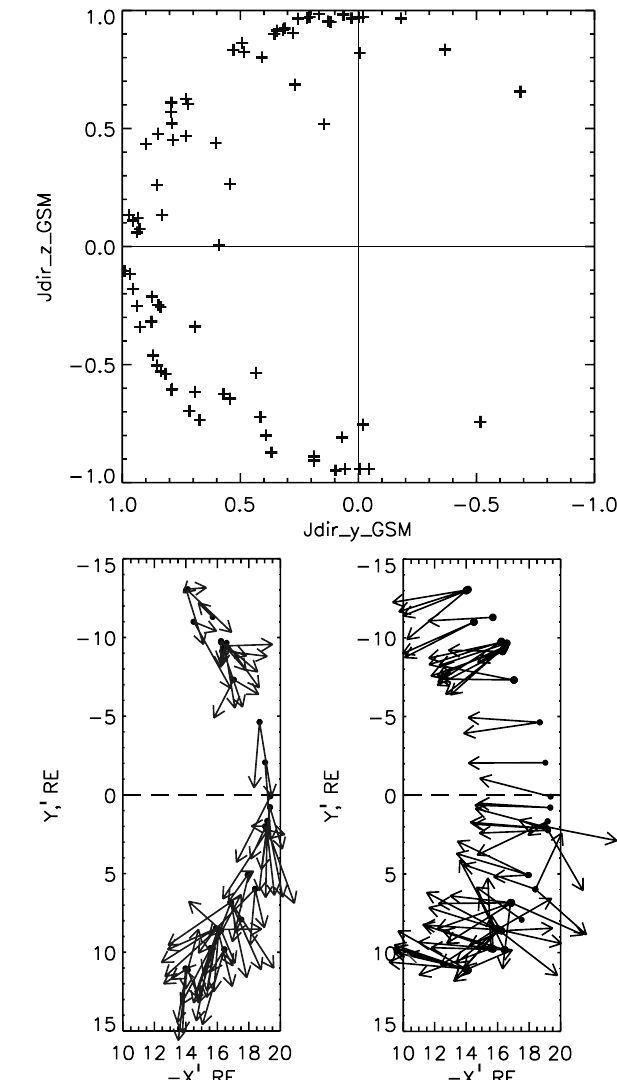
Fig. 7. Electric current and curvature directions. Upper panel: Distribution Y and Z components of the unit vectors e j = j /j ; Bot- tom panels: Projections of e j (left-hand panel), and projections of e C = C /C (right-hand panel) onto the X 0 − Y 0